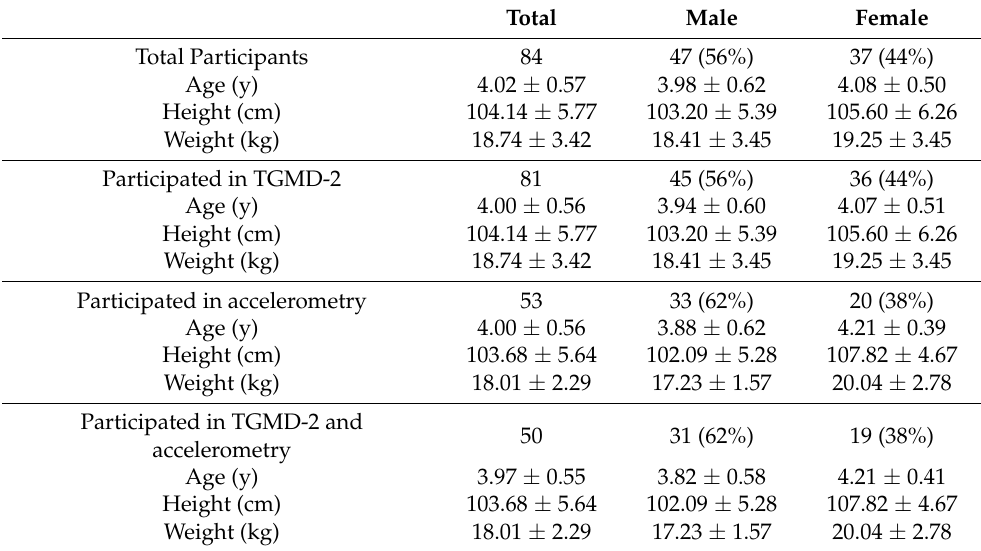
Table 1. Sample characteristics of participating